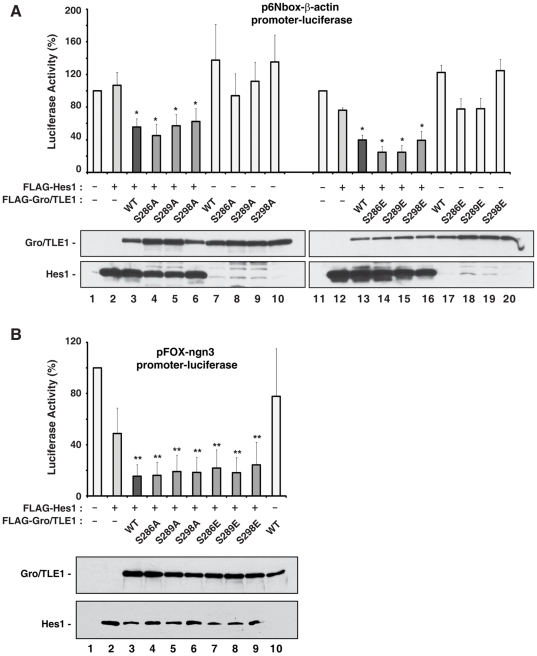
Effect of SP domain mutations on Gro/TLE1 transcriptional co-repressor activity in transiently transfected cells.HEK293 cells were transfected with reporter constructs containing the luciferase gene under the control of either the β-actin promoter linked to six tandem N-boxes (A) or a ∼3.0 kb fragment of the neurogenin3 promoter, which contains multiple N-boxes (B). Reporter plasmids were transfected alone (bar 1; luciferase activity considered 100%) or in combination with the following expression plasmids: pCMV2-FLAG-Hes1 (50 ng/transfection), pCMV2-FLAG-Gro/TLE1 (WT, S286A, S289A, S298A, S286E, S289E, or S298E) (100 ng/transfection), as indicated. Luciferase activities were expressed as the mean±the standard deviation of at least four separate experiments performed in duplicate; (*, P<0.01; **, P<0.001). Western blotting analysis of Gro/TLE1 and Hes1 proteins tested in the transcription assays, using an anti-FLAG antibody, is shown under each graph.